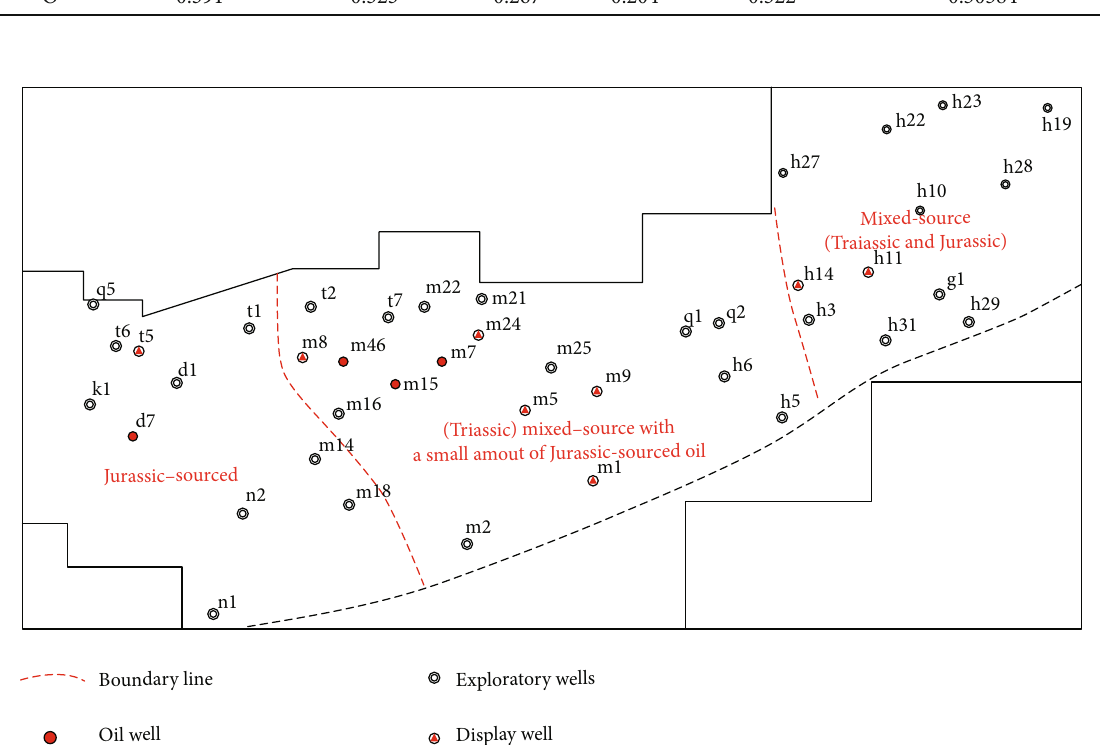
Figure 3: Horizontal distribution of Jurassic and Triassic oil and gas in the western Tabei